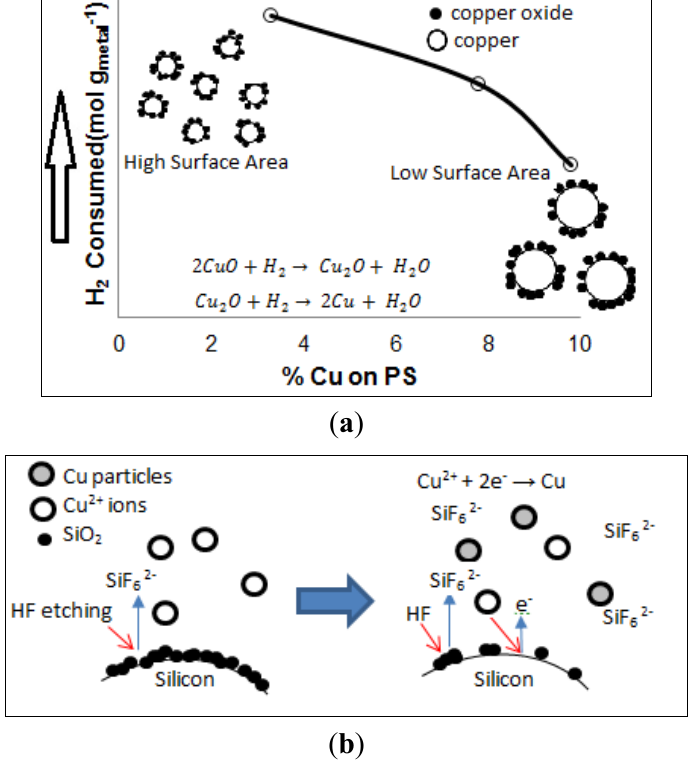
Figure 6. Schematic diagrams for ( a ) H 2 consumption and ( b ) H 2 production